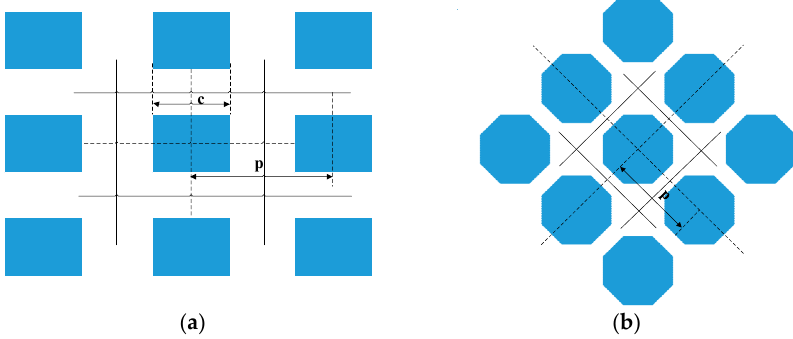
Figure 3. Partition results of the charge coupled device (CCD) sampling interval. ( a ) Partition result of traditional CCD; ( b ) Partition result of irregular CCD.